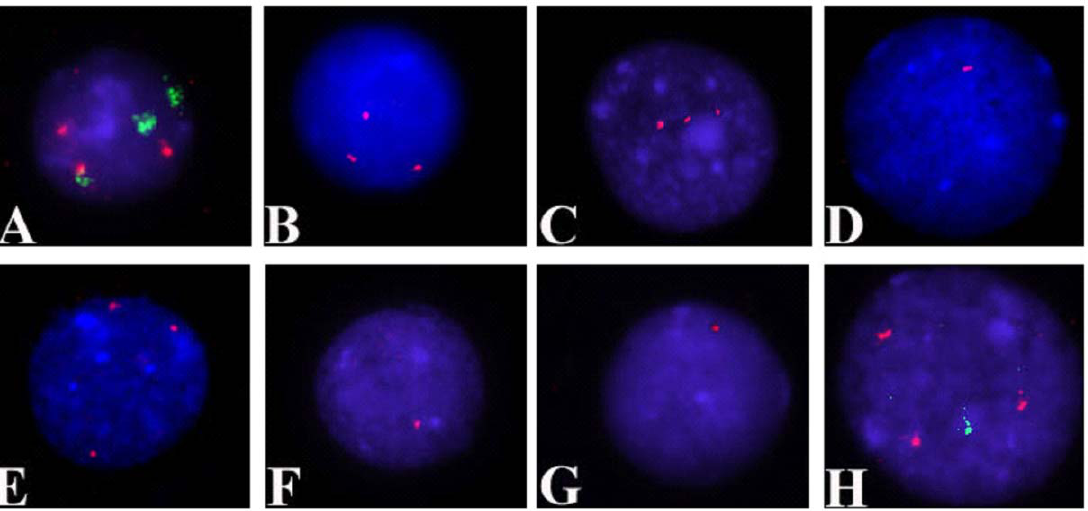
Figure 2. Representative FISH images confirming CNAs in the nuclei of patient samples. (A) Dual-colour FISH signals on nucleus of patient no. 1 confirm trisomy 7 and trisomy 8 in the same clone. Green signals correspond to chromosome 7 centromere, and red signals correspond to chromosome 8 centromere. (B) Trisomy 19 is shown on a nucleus of patient no, 2 using probe RP11-197O4 (hybridization signals in red). (C) Three red signals corresponding to probe RP11-399H11confirm the presence of three copies of 9q in patient no. 5. (D, E and F) FISH performed on patient no. 11 confirmed: (D) a monosomy of 7q22 as shown by the presence of one red hybridization signal corresponding to probe RP11-193I7; (E) a trisomy of 8q24.13 as shown by the presence of three red signals corresponding to probe RP11-16G11 and (F) a monosomy of 16p12 as shown by one red signals corresponding to probe CTD-2515A14. (G) In patient no. 12, monosomy of 15q21.1 is shown by one red signal corresponding to probe RP11-485O10 (H) Dual-colour FISH on a nucleus from patient no. 19 confirms the presence of a trisomy for 13q32.2 (three red signals corresponding to probe RP11-383H17) and monosomy of 4q35.2 (one green signal corresponding to RP11-45F23) in the same leukaemic clone.